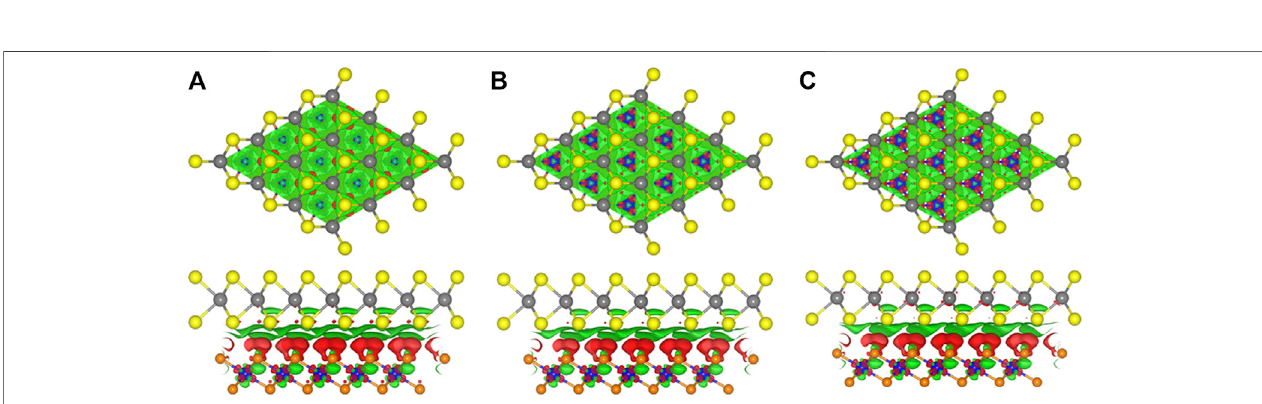
FIGURE 4 | Isosurface of the charge density difference of the MP vdW heterostructure under the strains of (A) – 4%, (B) – 2%, and (C) 2%; red and green marks demonstrate the losing and gaining of electrons, respectively. The isosurface parameter is 0.001 |e|.